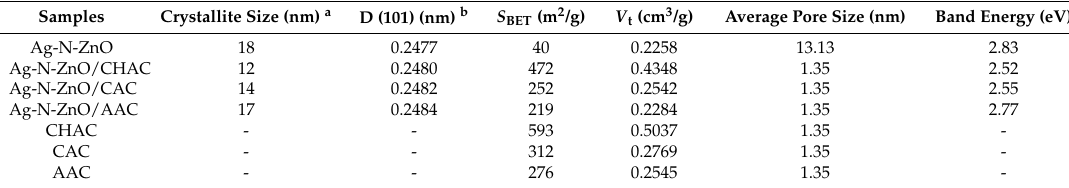
Figure 1. XRD patterns of Ag-N-ZnO ( a ), Ag-N-ZnO/CHAC ( b ), Ag-N-ZnO/CAC ( c ), and Ag-N-ZnO/AAC ( d ). Table 1. Characteristics of different photocatalysts.